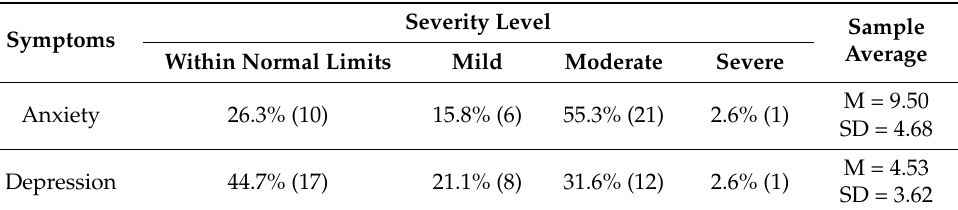
Table 1. Baseline parent proxy PROMIS anxiety and depressive symptoms scores for Teddy bear lab